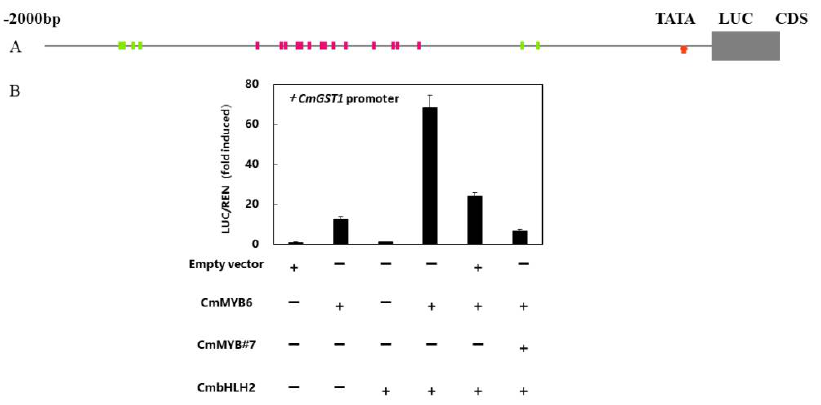
Figure 7. Regulatory effect of CmMYB6 , CmbHLH2 and CmMYB#7 on the CmGST1 promoter. ( A ) Schematics of CmGST1 promoter, green rectangles meant that MYB recognized cis -elements and red rectangles meant that bHLH recognized cis -elements. TATA was labeled by a red arrow. ( B ) The regulatory effects of CmMYB6 , CmbHLH2 and CmMYB#7 on the CmGST1 promoter used dual-luciferase analysis. Data were means ( ± SE) from three independent biological replicates.